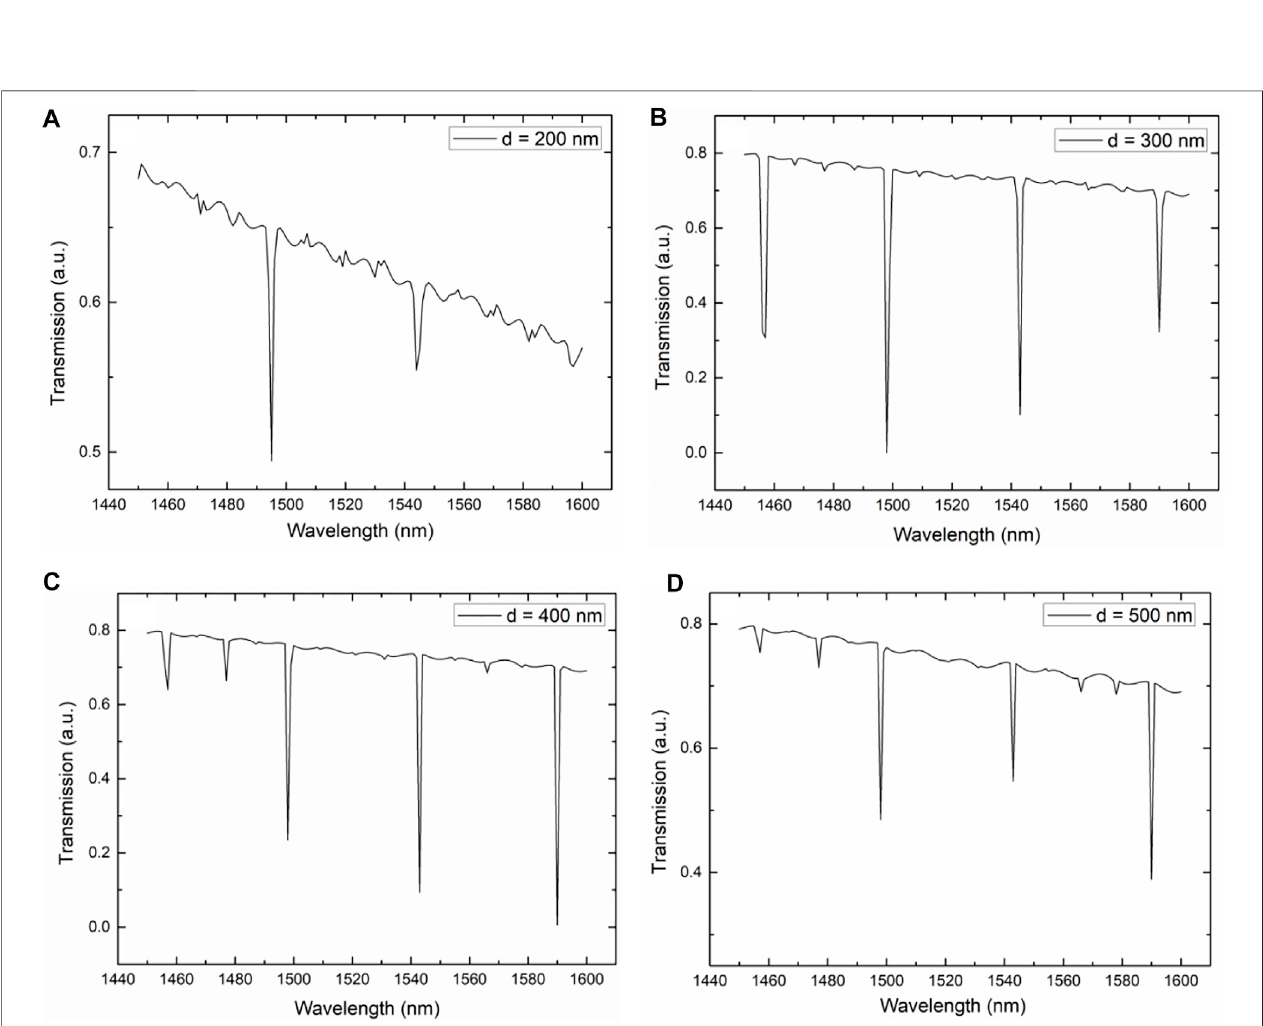
FIGURE 4 | Transmission curve of the device for different distances between the ring and bus waveguide varying from 200 to 500 nm by 100 nm.